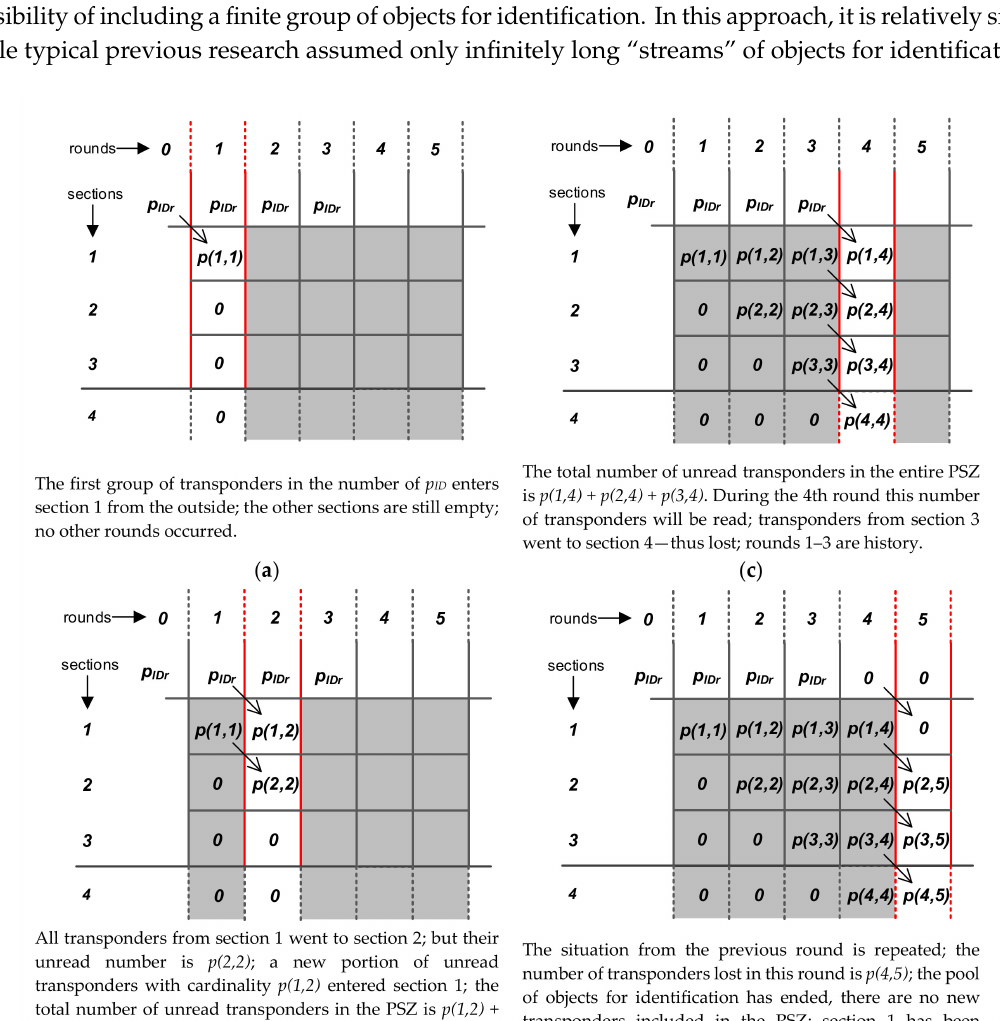
Figure 8. Possibilities of presenting an example of the system state in rounds and sections using matrix notation: ( a ) first round; ( b ) second round; ( c ) fourth round; ( d ) fifth round.